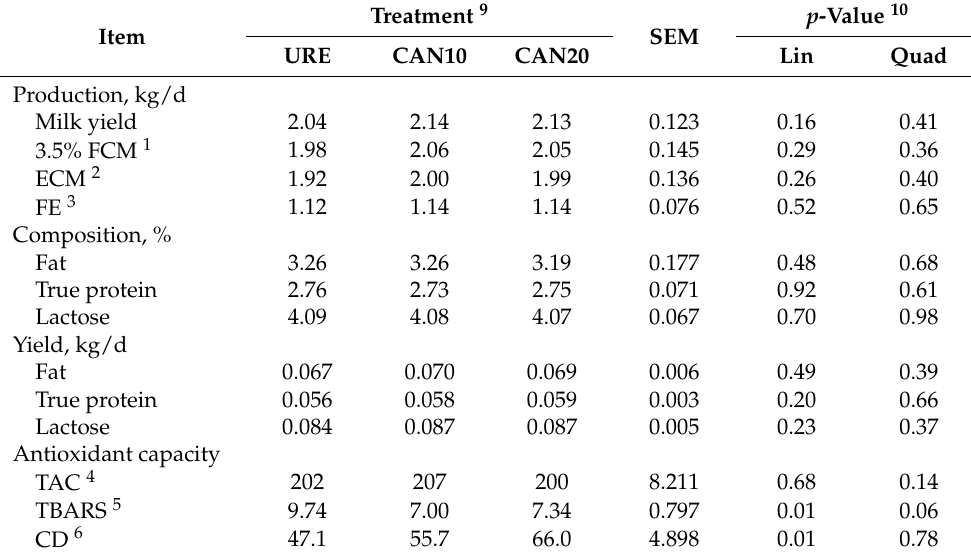
Table 3. Effects of calcium-ammonium nitrate (CAN) fed to lactating dairy goats on milk production, composition, yield, and antioxidant